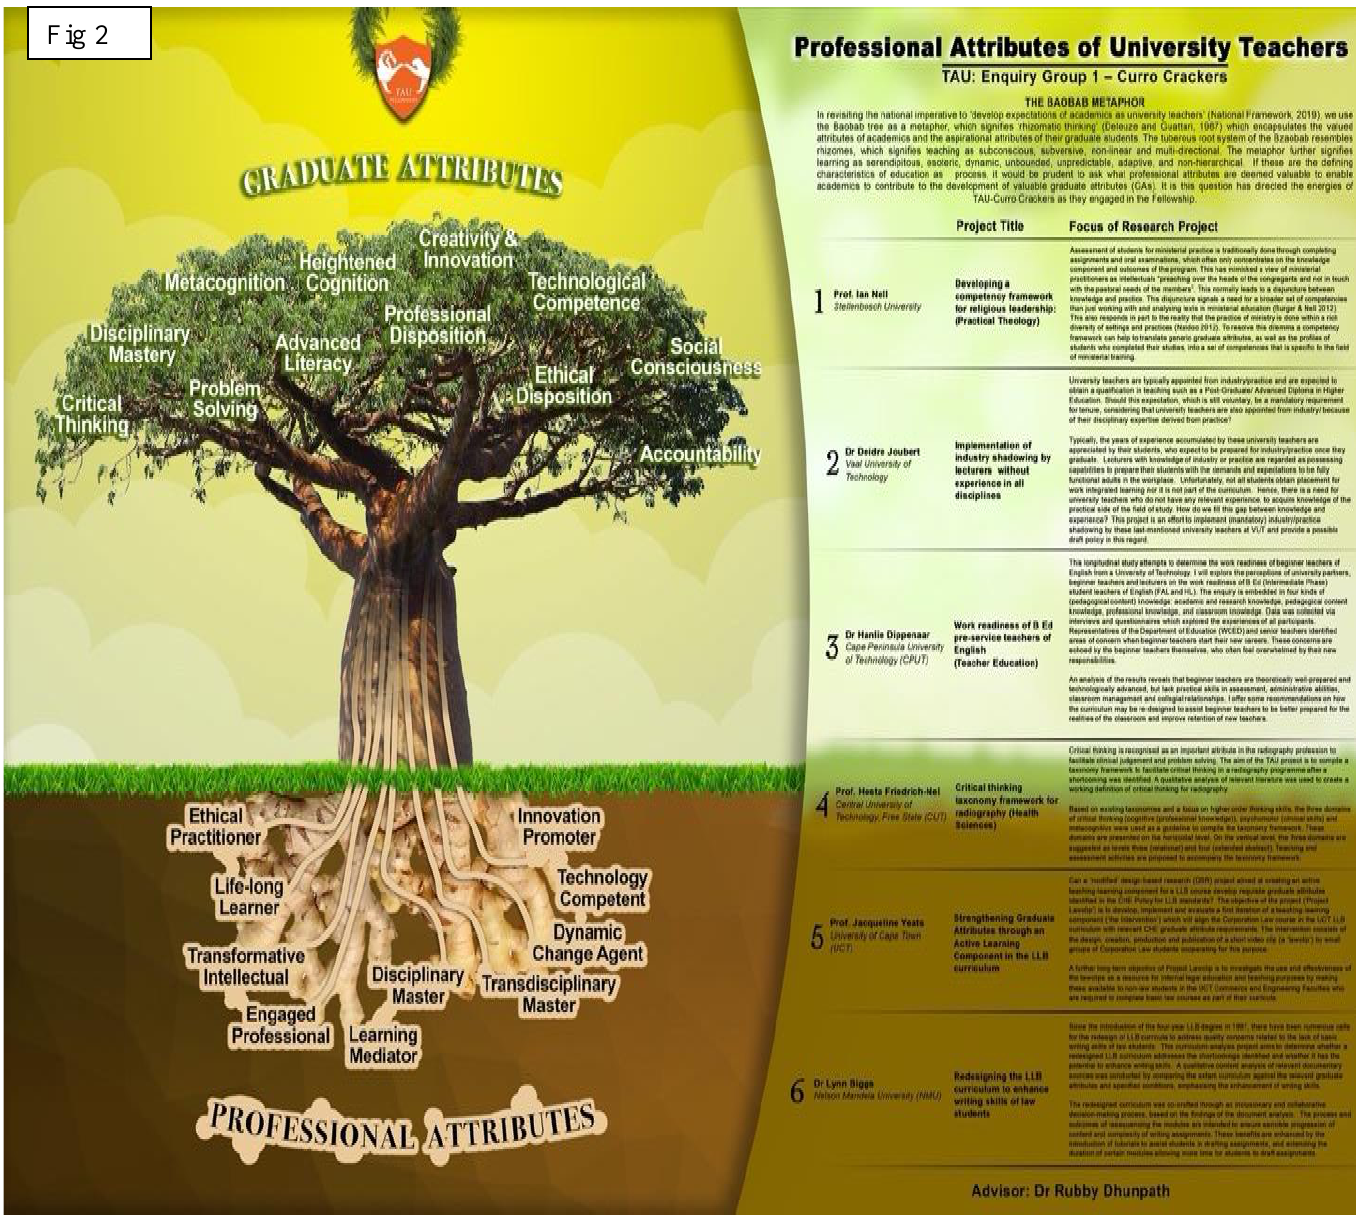
Figure 2 : Baobab